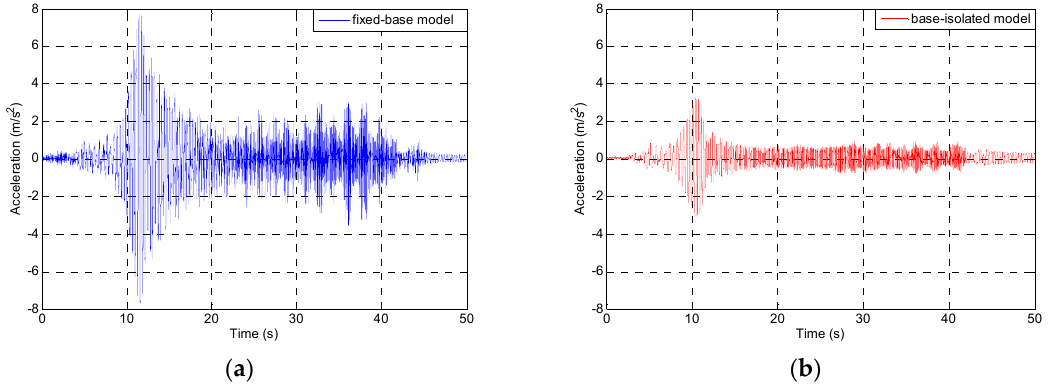
Figure 9. Time-acceleration history plots for the fixed-base ( a ) and base-isolated ( b ) single-storey model during the sine sweep test.